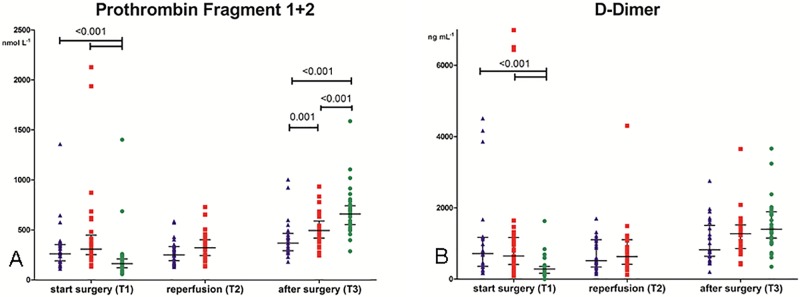
Markers of coagulation activation.Fig 3A: Levels of prothrombin fragment 1+2. Preemptive group (blue triangle), non-preemptive group (red square) and donors (green dot) before incision (T1), 5 minutes after reperfusion (T2) and 2 hours after surgery (T3). Data are given as medians with IQR. Fig 3B: Levels of D-dimer. Preemptive group (blue triangle), non-preemptive group (red square) and donors (green dot) before incision (T1), 5 minutes after reperfusion (T2) and 2 hours after surgery (T3). Data are given as medians with IQR.